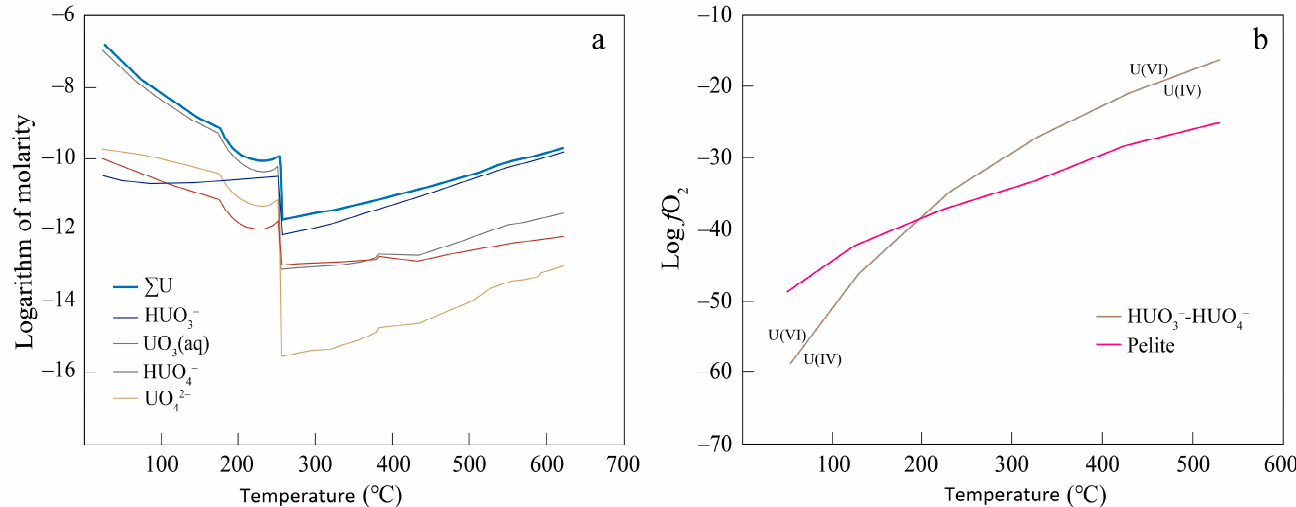
Figure 3. ( a ) The contents of different U-bearing species in fluids released from “oxidized” pelite over a temperature range of 25–650 °C at a constant pressure (2 kbar); ( b ) comparison of calculated over a temperature range of 25–650 ◦ C at a constant pressure (2 kbar); ( b ) comparison of calculated log ƒ O 2 of HUO 3– -HUO 4– and the “oxidized” pelite at different temperatures. The calculated log ƒ O 2 log f O 2 of HUO 3 − -HUO 4 − and the “oxidized” pelite at different temperatures. The calculated log f O 2 of HUO 3– -HUO 4– represents the log ƒ O 2 values for the transitions between U(IV) and U(VI). of HUO 3 − -HUO 4 − represents the log f O 2 values for the transitions between U(IV) and